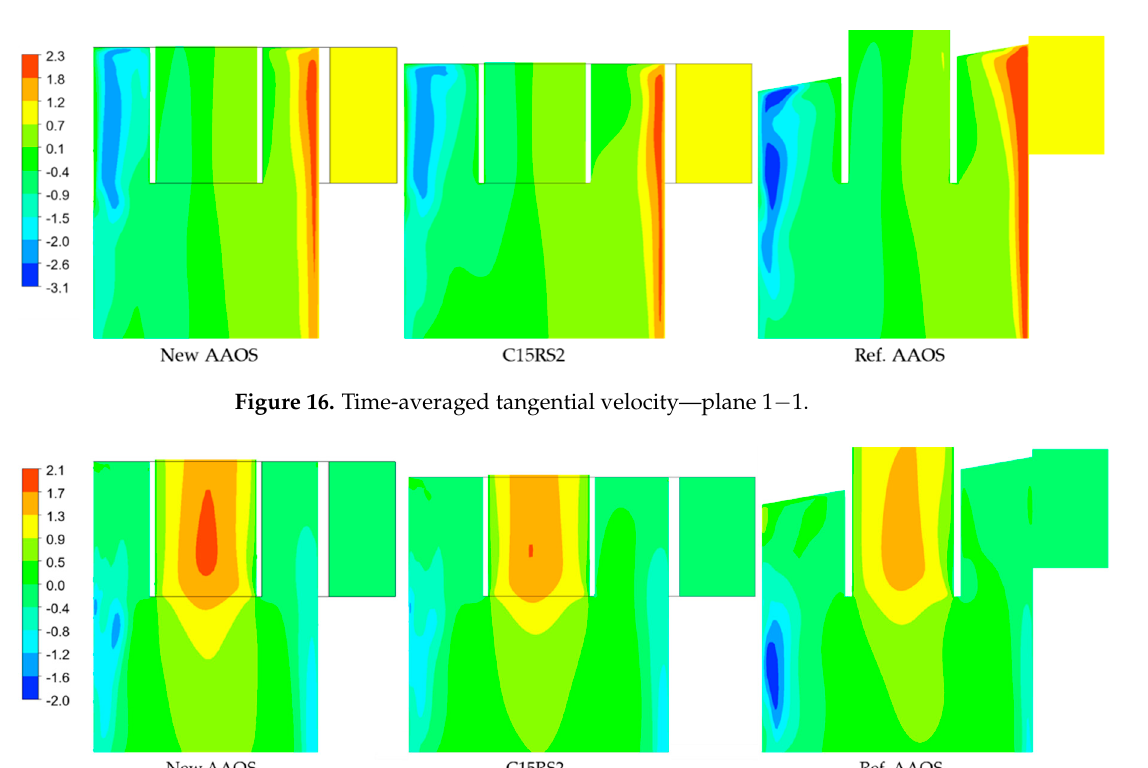
Figure 17. Time-averaged axial velocity—plane 1 − 1.